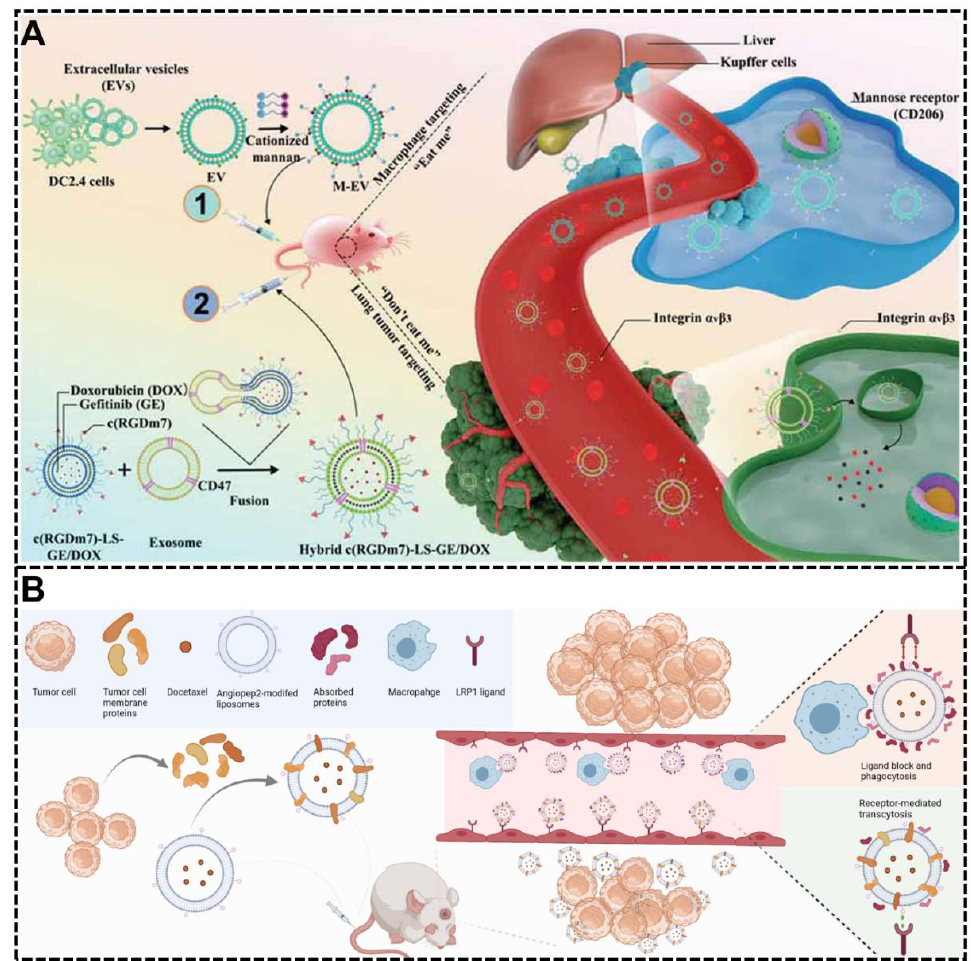
Figure 6. Exosomes-based decoration to harness protein corona. ( A ) A combined “eat me/don’t eat me” strategy with a bio-inspired NP system using exosome-based decoration was proven to have prolonged circulation time and increased tumor accumulation by controlling the protein corona and achieving macrophage escape [76]. Copyright 2020 Wiley-VCH. ( B ) A novel bio-inspired NP system by multifunctional exosome-mimetics (EM) was developed to target glioblastoma (GBM) drug delivery by controlling protein corona formation, escaping phagocytosis, enhancing BBB penetration, and GBM targeting [77]. Copyright 2021, Springer